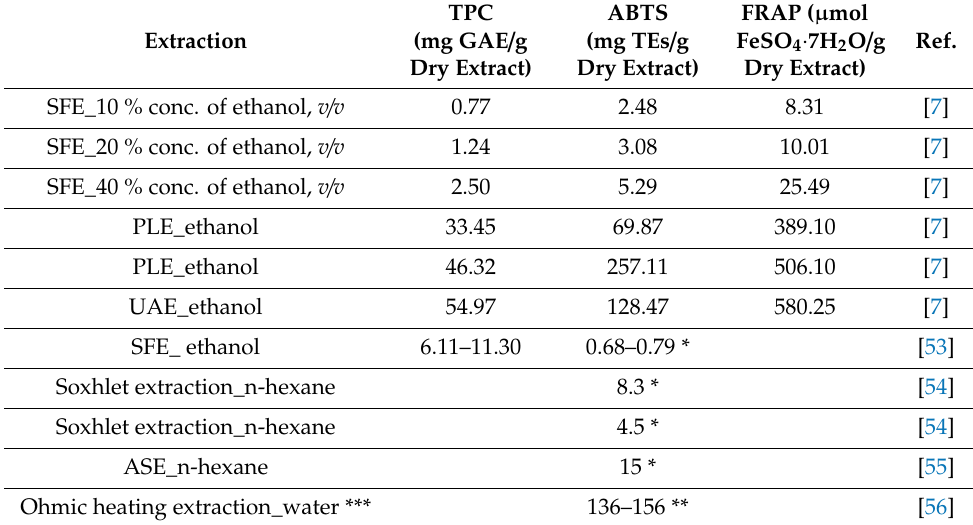
Table 1. Total phenolic content (TPC) and antioxidant activity of spruce and pine